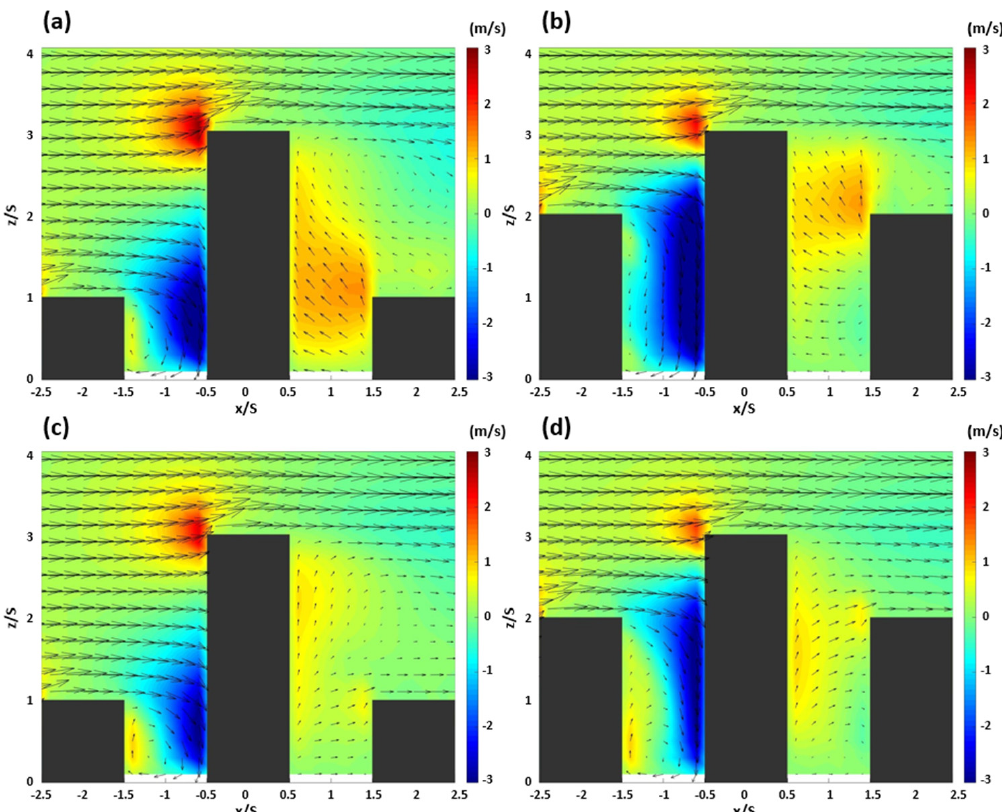
Figure 4. Wind field and vertical wind component of y/S = 0 (upper panel) and y/S = [0.3 and − 0.3] (lower panel) with numerical simulations in the cases of the shallow canyon ( a , c ) and the deep canyon ( b , d ).